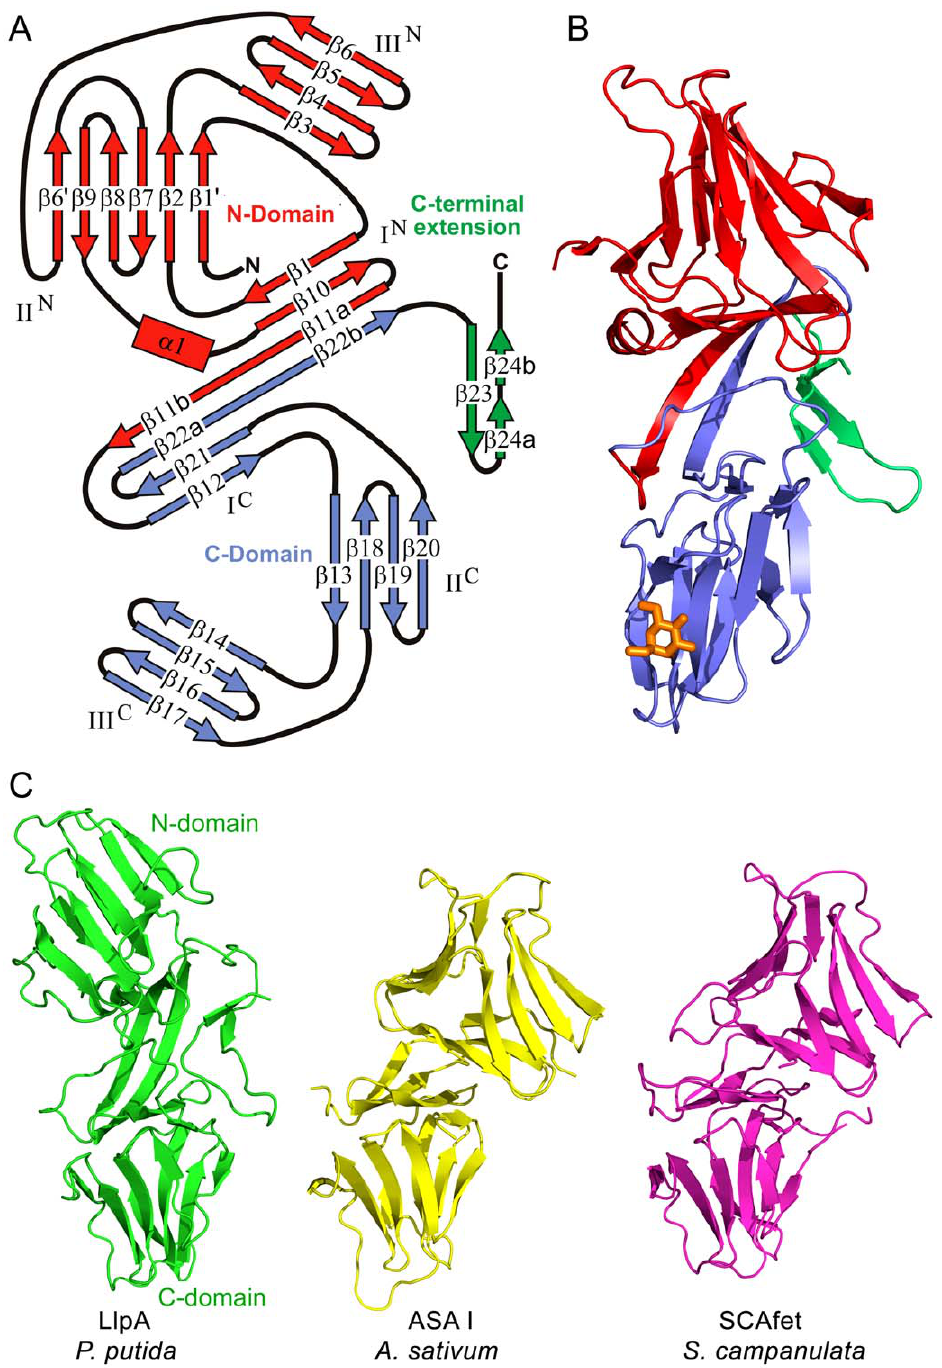
Figure 1. Overall structure of LlpA BW . (A) Topology diagram of LlpA BW . The N-domain is shown in red, the C-domain in blue and the C-terminal extension in green. The different strands and subdomains are labeled. Domain swapping involves b -strand segments b 11b and b 22b, which together with b -strand segments b 11a and b 22a link both MMBL domains. (B) Cartoon representation of LlpA BW with the different domains colored as in panel A. The bound Me-Man residue is shown as an orange stick representation. (C) Domain orientations of LlpA BW compared with the heterodimeric MMBL ASA I ( Allium sativum agglutinin, PDB entry 1KJ1) and tandem MMBL SCAfet ( Scilla campanulata fetuin-binding lectin, PDB entry 1DLP). In each case, the C-domain is shown in the same orientation, highlighting the different relative orientation of the N-domain in LlpA BW . Domain-swapped dimers in homo-oligomeric plant MMBL lectins such as snowdrop lectin have their domain orientation similar to ASA I and SCAfet.